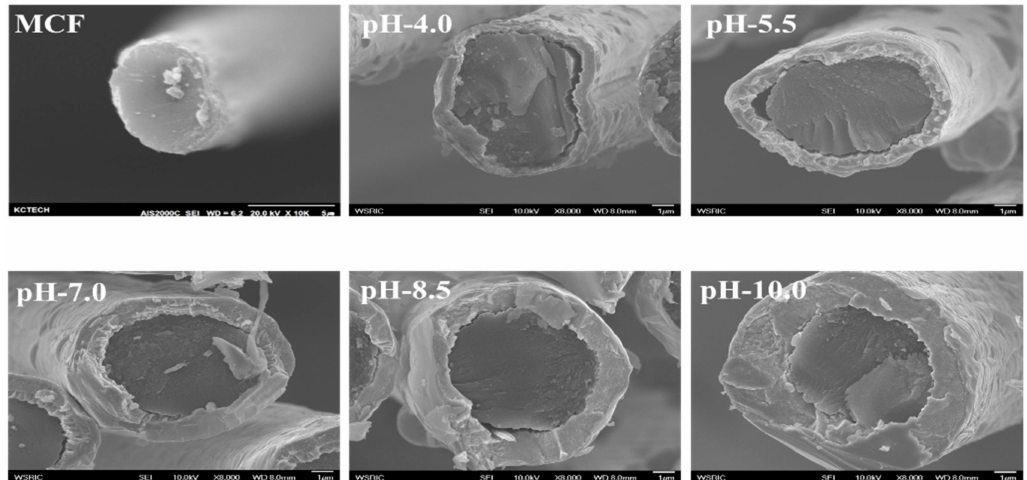
Figure 8. SEM images of MCF as a function of the pH of the plating